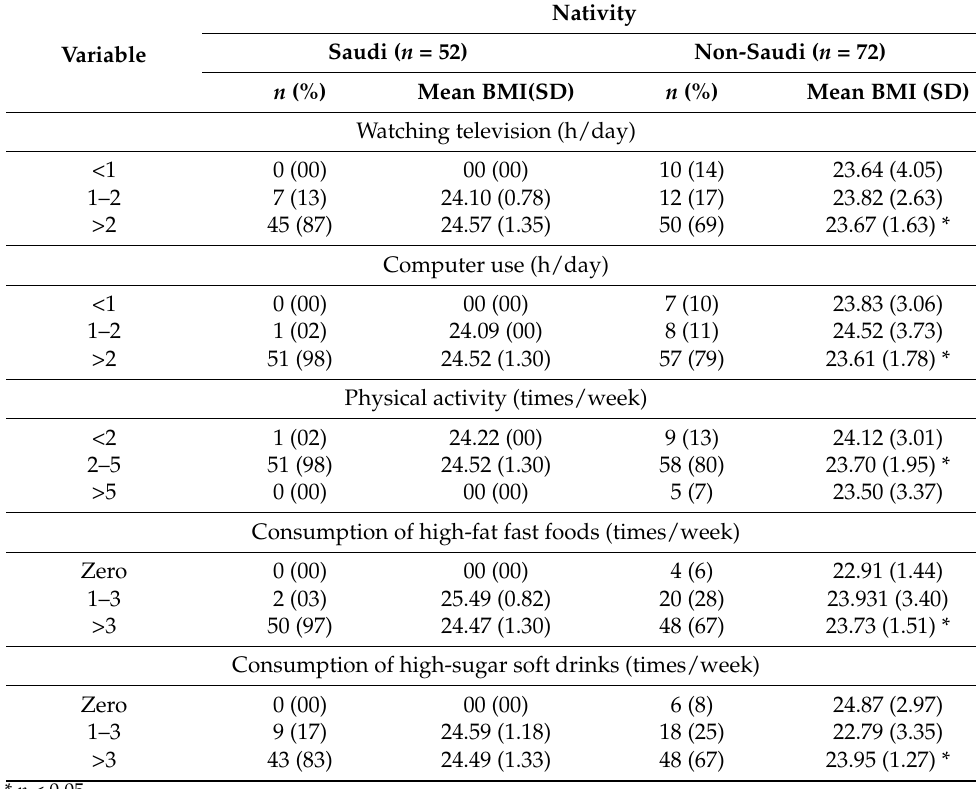
Table 3. Nativity based variations in lifestyle behaviors (watching television, computer use, physical activity, and food preferences) and their relationships to mean body mass index (BMI) among